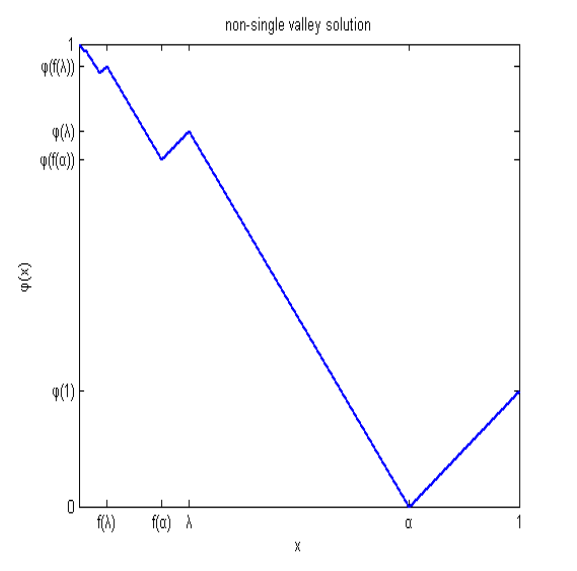
Fig. 1. The graph of non-single-valley